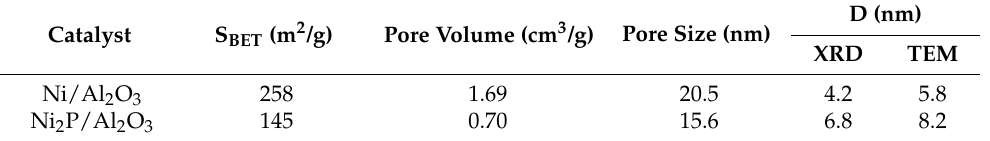
Figure 1. X-ray diffraction (XRD) patterns of the Ni/Al 2 O 3 and Ni 2 P/Al 2 O 3 catalyst. Table 1. Textural and structural properties of the Ni/Al 2 O 3 and Ni 2 P/Al 2 O 3 catalyst.